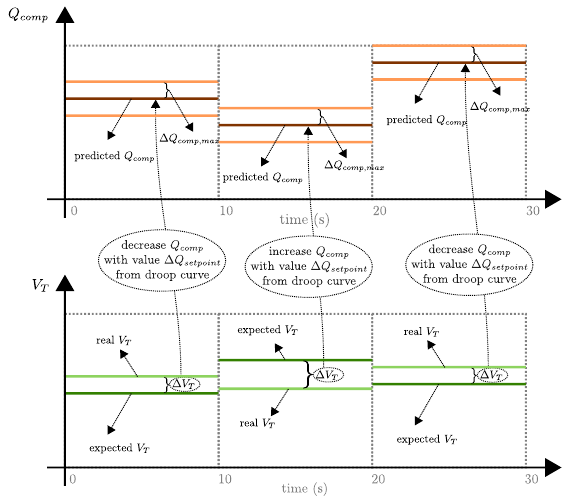
Figure 21. Illustration of the on-board adaptation, supported by the predicted Q comp and V T , estim . from the smart railways